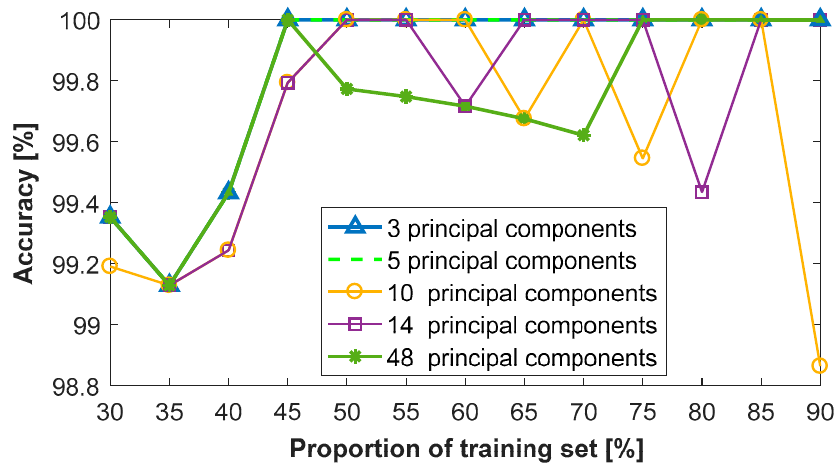
Figure 11. Classification results of the SVM-kNN classifier with different principal components.